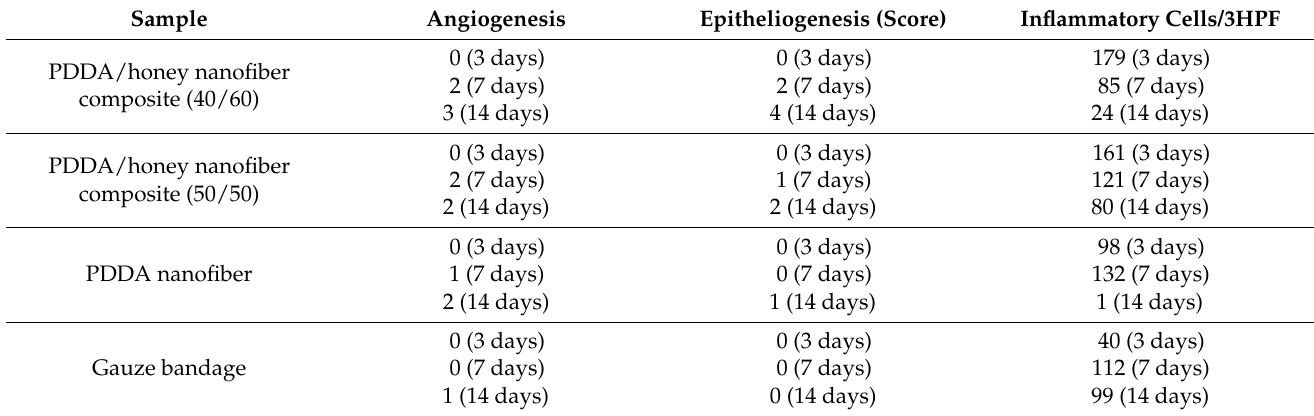
Table 1. Histomorphometric analysis of wounds after treatment with different